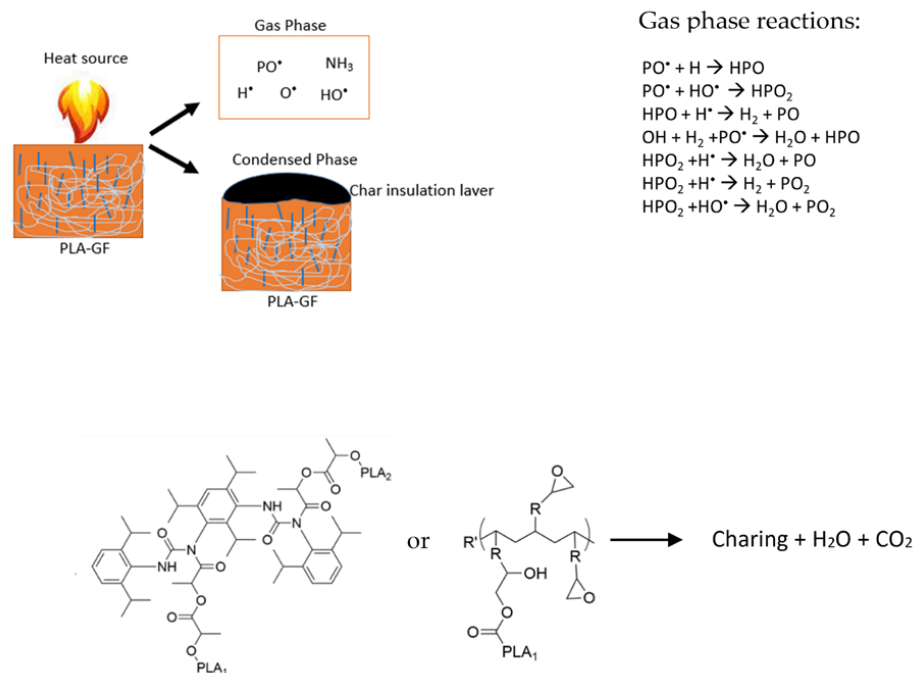
Figure 6. Possible flame retardant mechanism of PLA GF